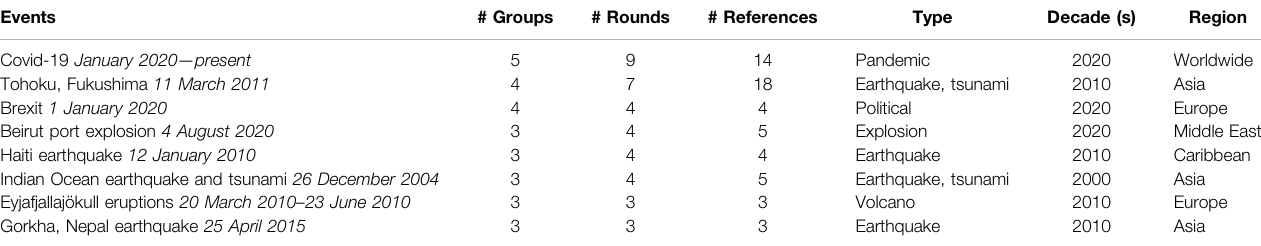
TABLE 1 | Speci fi c case studies referred to by three or more groups (Section 3.4) . The full list of case studies used is available in Supplementary Document S4 . The Gorkha, Nepal earthquake was mentioned as an example in the brie fi ng presentation. Events #